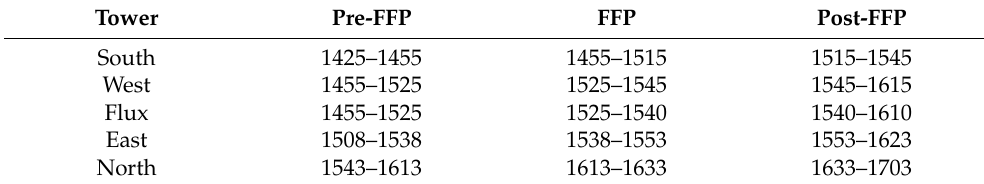
Table 1. Time periods (LT) for the delineated pre-FFP, FFP, and post-FFP periods at each tower located in the interior of the prescribed burn